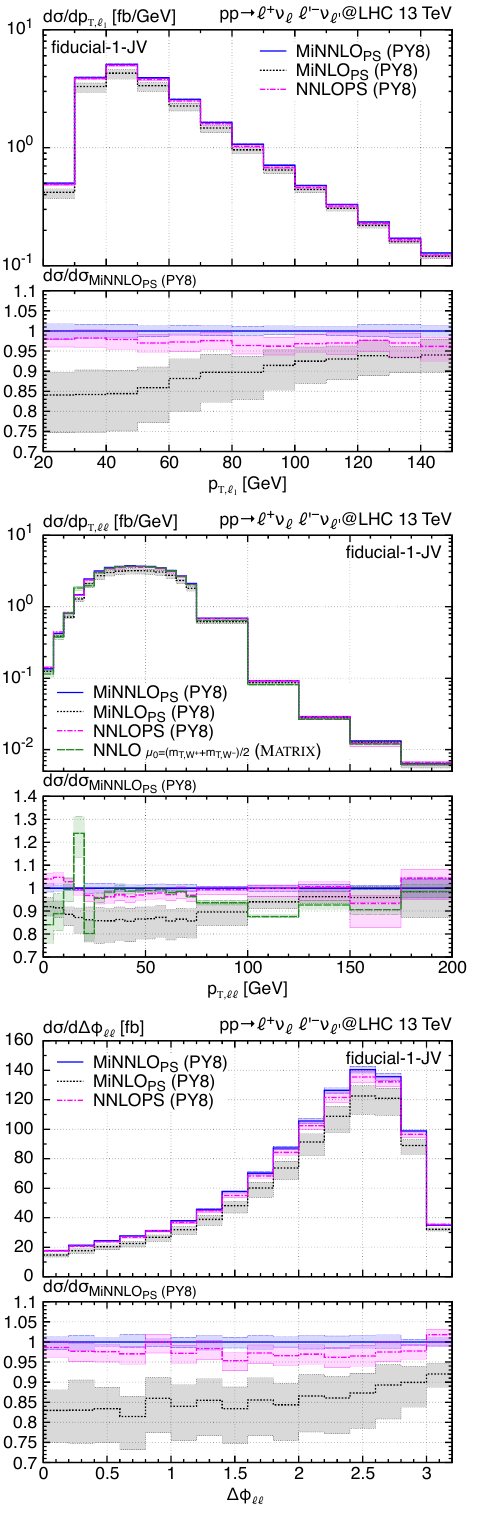
Figure 8. Differential distributions in the fiducial-1-JV phase